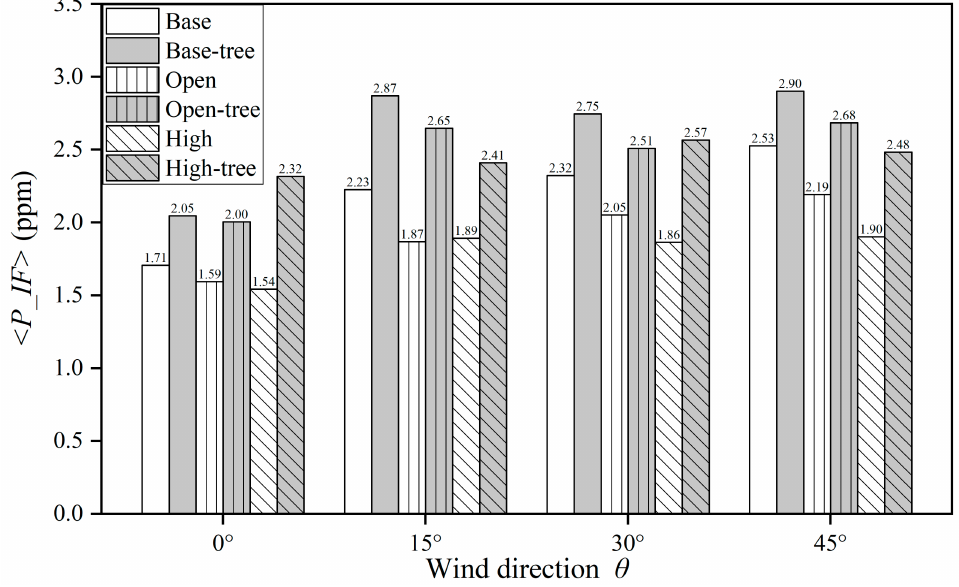
Figure 10. Building intake fraction < P_IF> in all